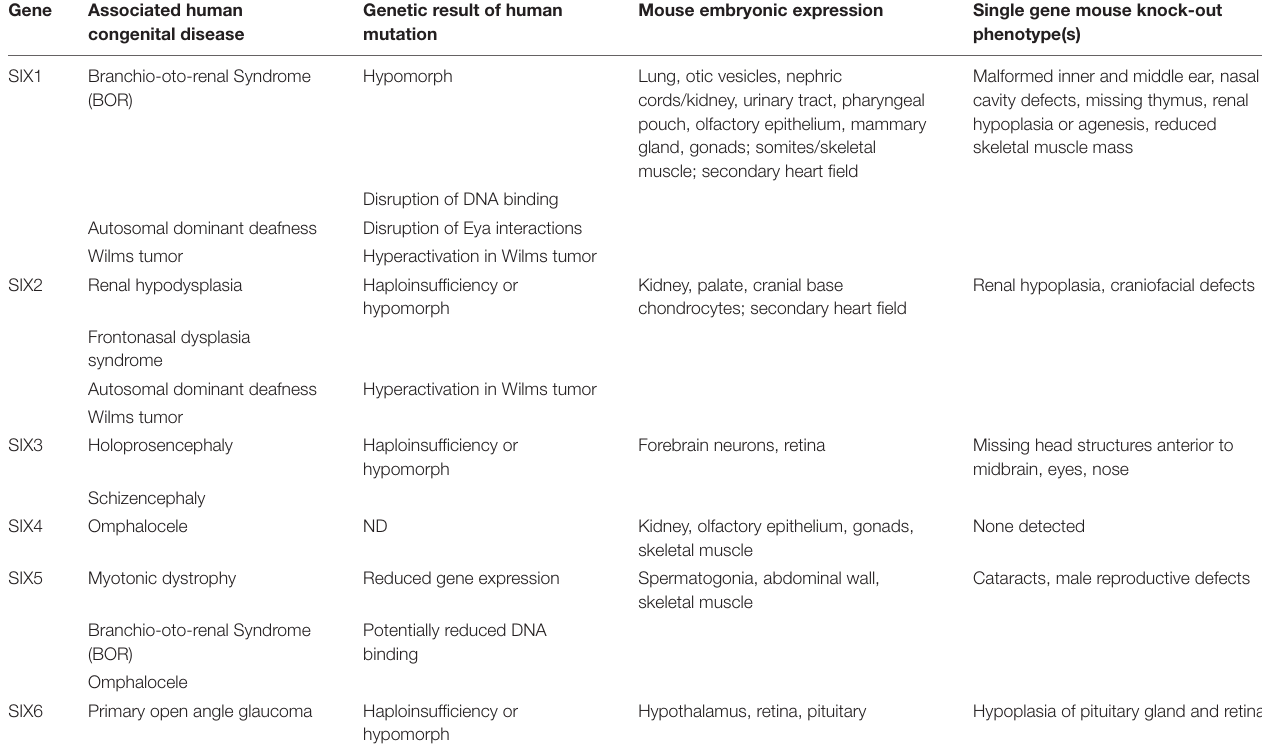
Mouse embryonic expression